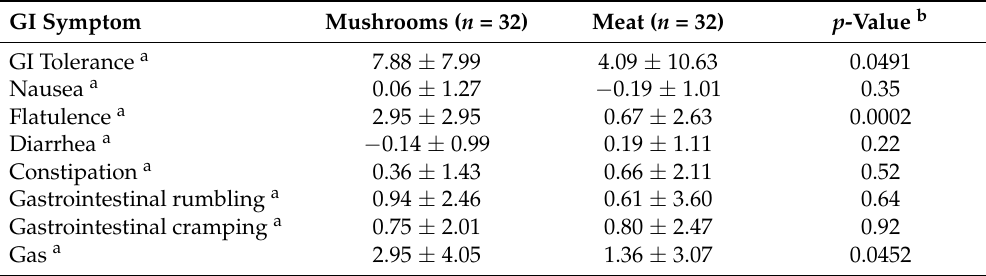
Table 4. Gastrointestinal tolerance measures day 1.